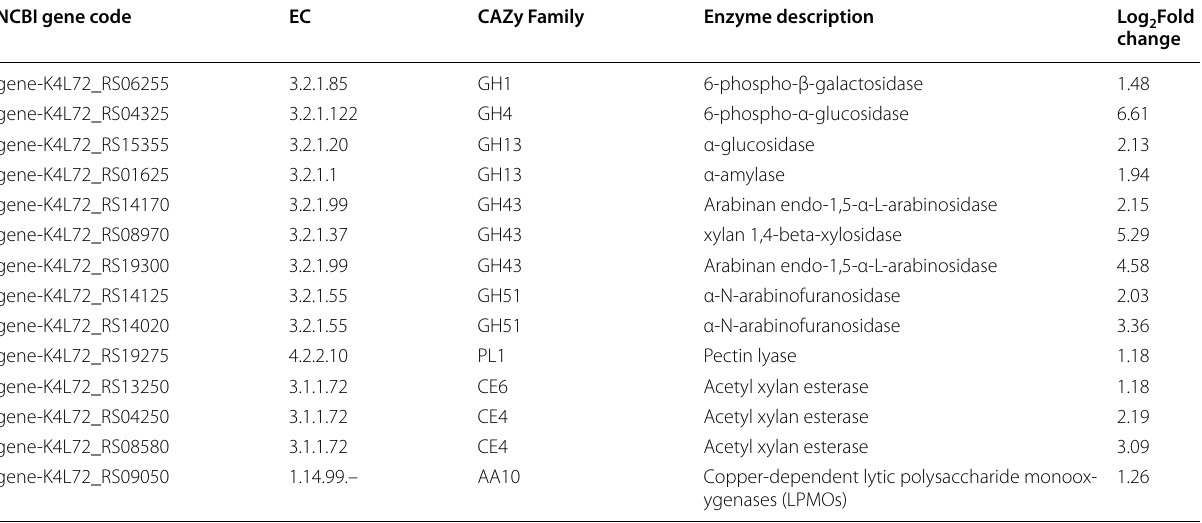
Table 2 CAZymes-encoding genes with significantly increased expression in the transcriptome of B. velezensis CL-4 fermented corn germ